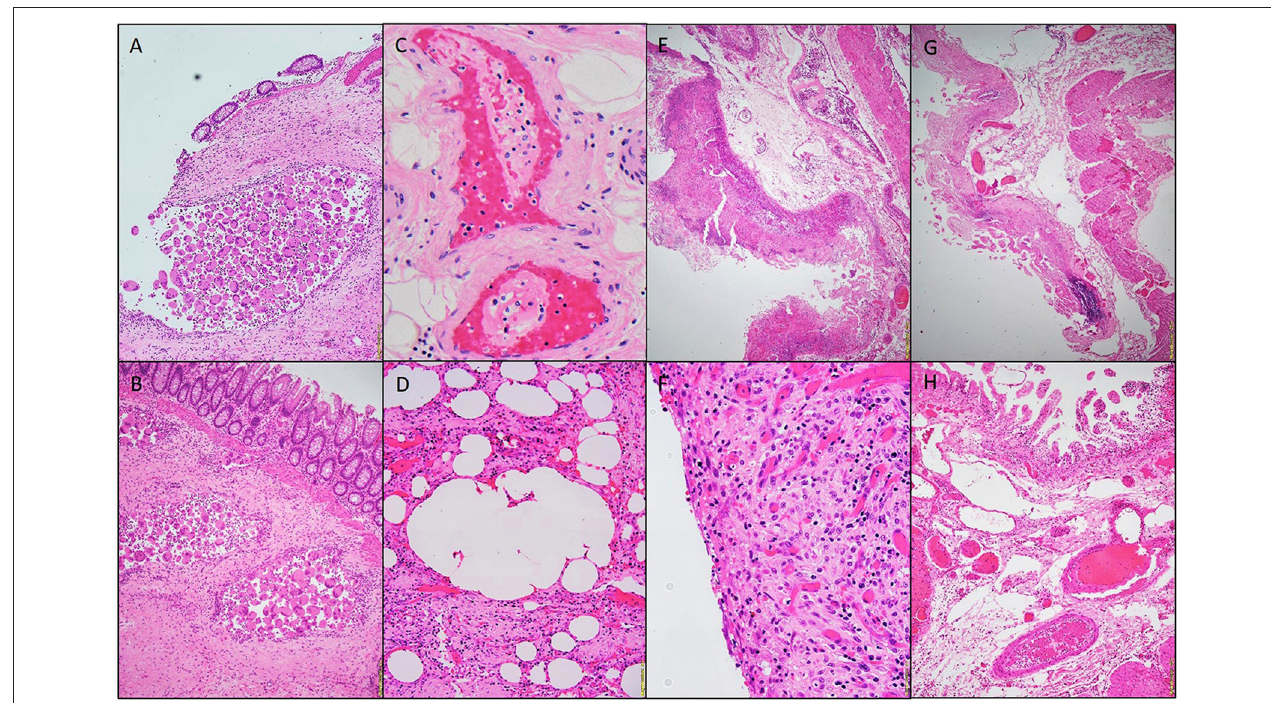
FIGURE 1 | Photomicrographs of a hemicolectomy specimen. Aggregates of multinucleated giant cells lining the cysts. H&E stain 20x (A,B) . Fibrin thrombi, H&E staining 40x (C) . Micro-cyst lined with multinucleated giant cells, H&E staining 10x (D) . Pseudomembrane, H&E 10x (E) . Acute serositis, H&E staining 40x (F) . Ischemic enteritis, H&E 10x (G) . Submucosal thrombi, H&E 10x (H) .